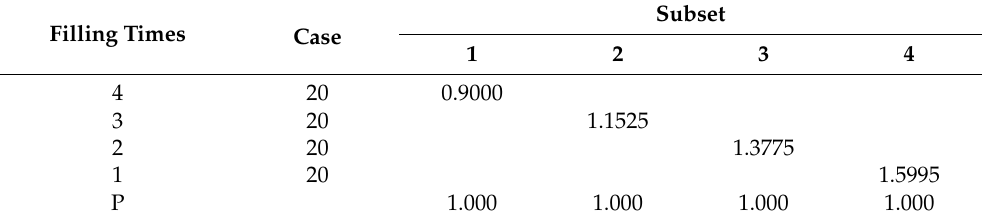
Table 5. Pairings comparison of filling